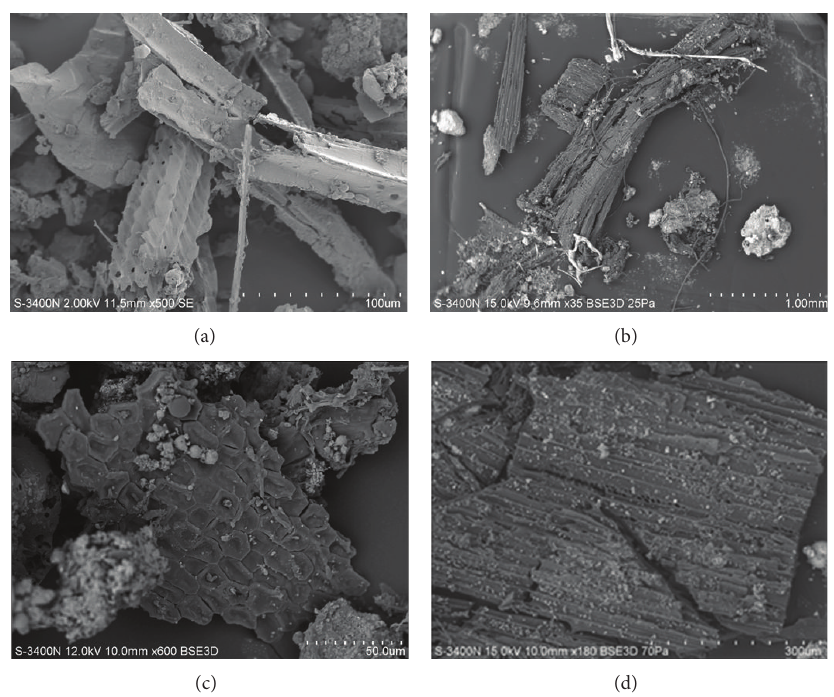
Figure 1: Electronic micrography: (a) fragments of leaves from a snow sample taken in the area of the ring motorway in Birobidzhan. Magnification × 500.(b)WoodparticlesfromasnowsampletakenattheexhibitionareainBlagoveshchensk.Magnification × 35.(c)Fragments of leaves from a snow sample taken in the center of Bastak nature reserve. Magnification × 600. (d) Wood particles from a snow sample taken at the intersection of Partizanskaya and Lenin streets in Blagoveshchensk. Magnification ×